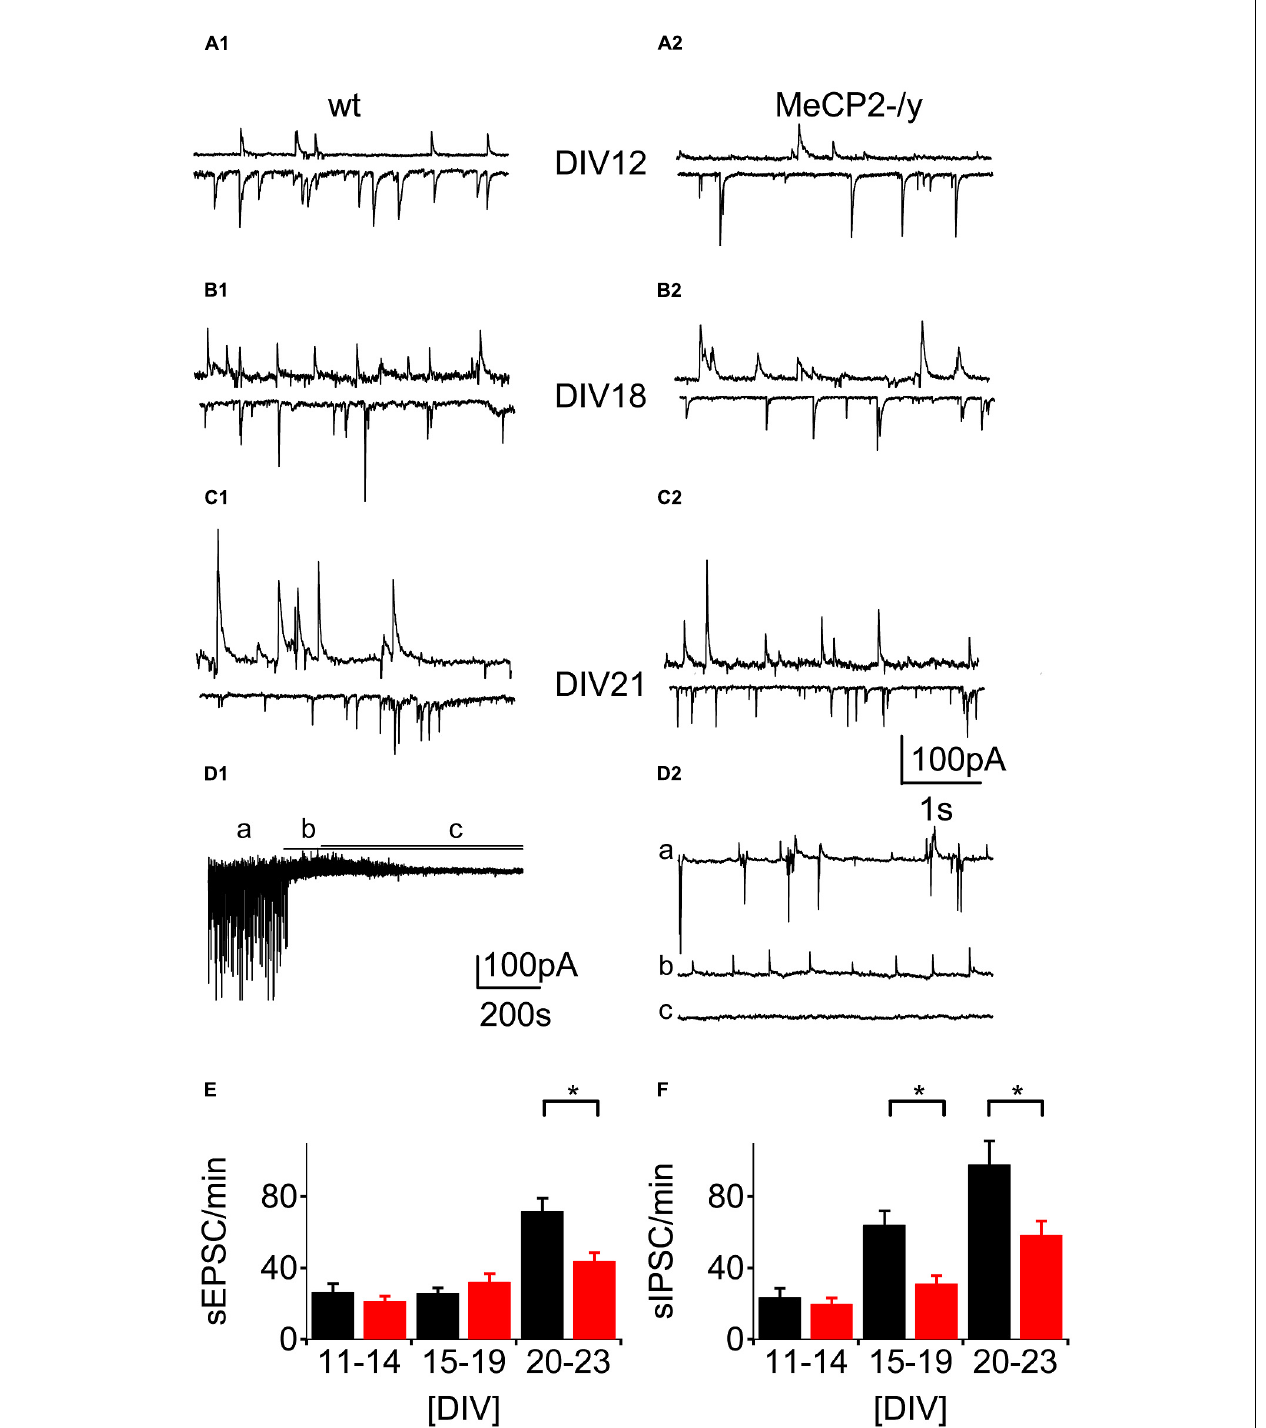
FIGURE 4 | Synapticactivityasafunctionofdevelopment.(A–C) Tracesof spontaneousactivityinvoltage-clamp.Toptracesat − 40mVholdingpotential bottomtracesat − 60mV,respectively. (D) Pharmacologicalcharacterizationof synapticcurrents. (D1) Sampletraceofoneexperimentwithbaselinerecording